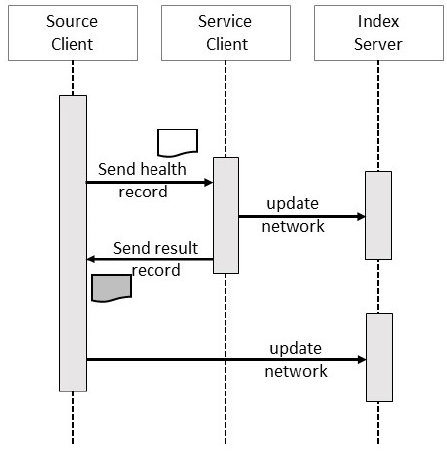
Figure 4. Service Operation. This operation is used by the patient to request an e-health service from a third